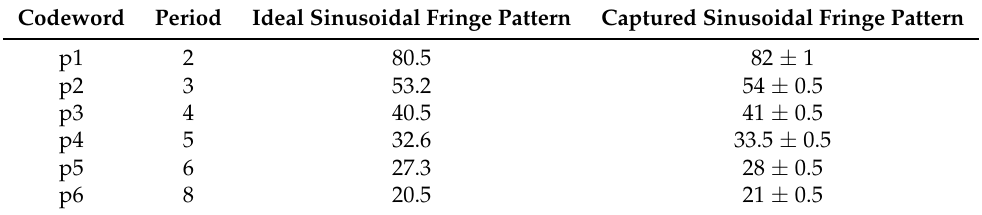
Table 1. Frequency component of each phase